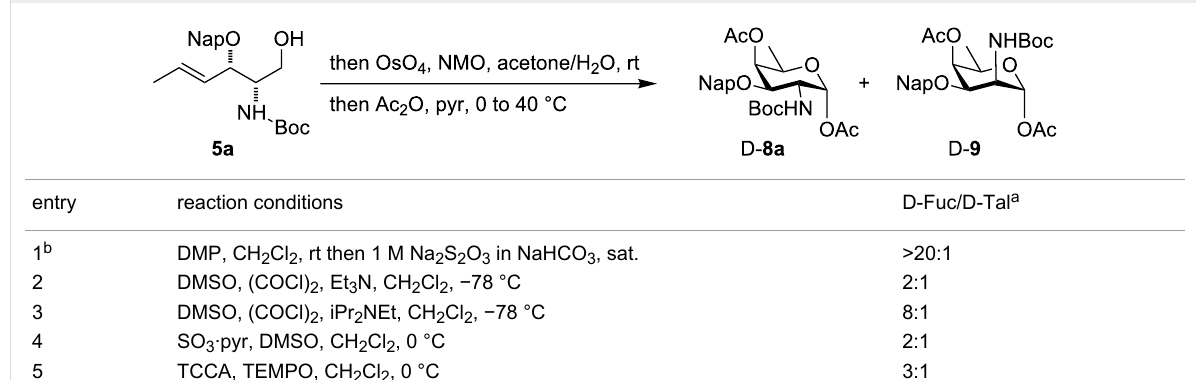
Table 2: Oxidation of 5a to D-fucosamine D- 8a